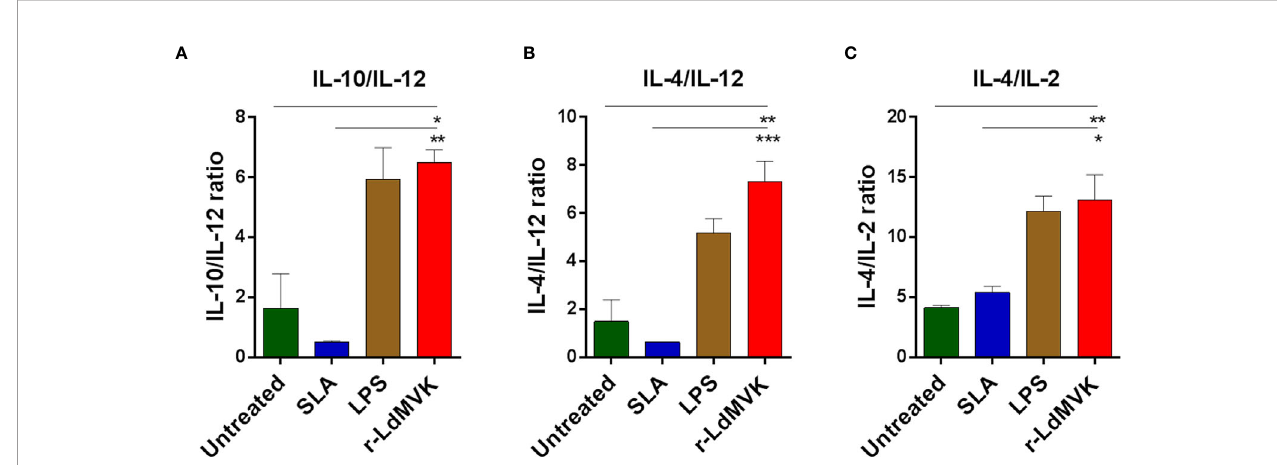
FIGURE 4 | Secreted level of cytokines in macrophages after r-LdMVK stimulation. (A) IL-10/ IL-12, (B) IL-4/ IL-12, and (C) IL-4/ IL-2 cytokine ratio of PBMC of healthy control, cultured in the presence of r-LdMVK, soluble Leishmania antigen (SLA), or lipopolysaccharide (LPS). PBMC was assessed for their effect on various cytokines release: IFN g , IL-12p70, TNF ⍺ , IL-10, IL-2, and IL-4. Levels of cytokines were measured by ELISA after 16 h treatment. Unstimulated culture was used as a control. The data represents mean±SE of three independent biological replicates (including three technical replicates). p value < 0.05 is denoted by *, p value ≤ 0.01 is denoted by ** and p value ≤ 0.001 is denoted by ***.